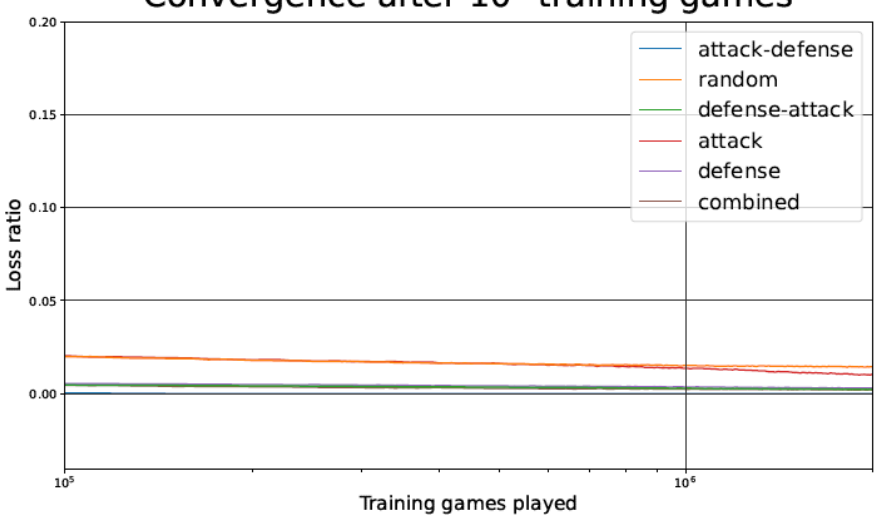
Figure 6. Tic-tac-toe TD agent loss ratio after 100,000 games as a function of the number of games played, for the different training strategies.